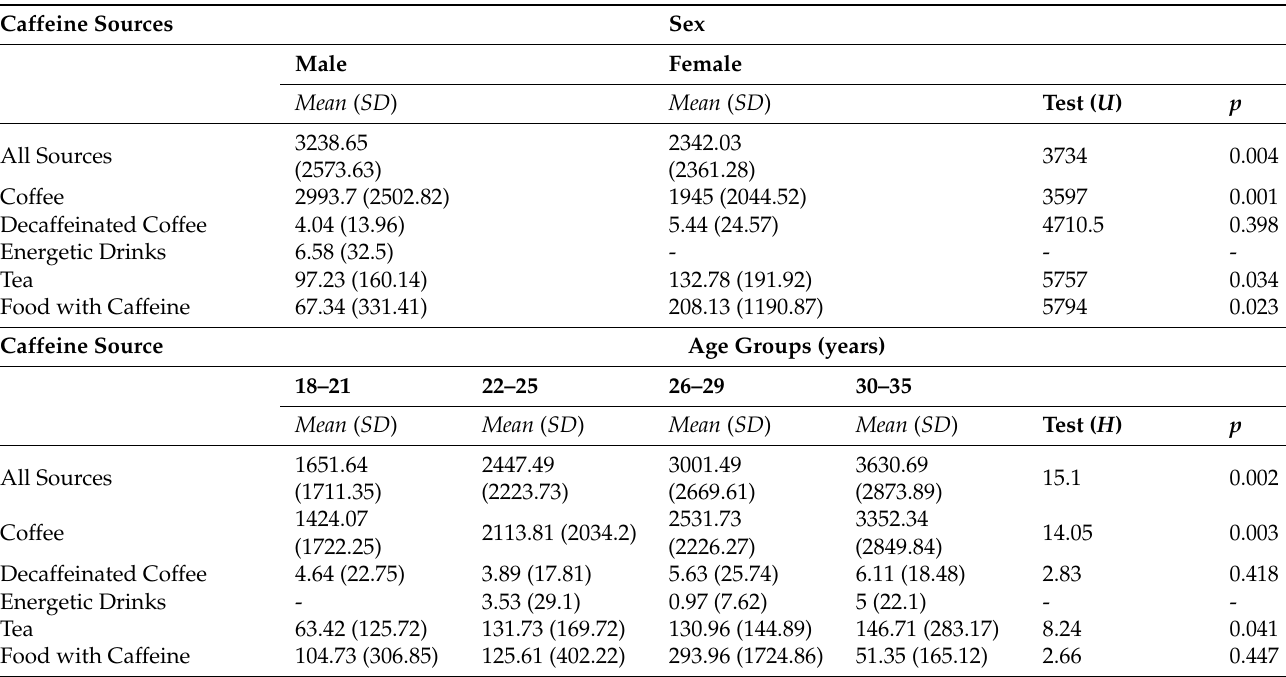
Table 2. Sources and concentrations of caffeine consumption by sex and age